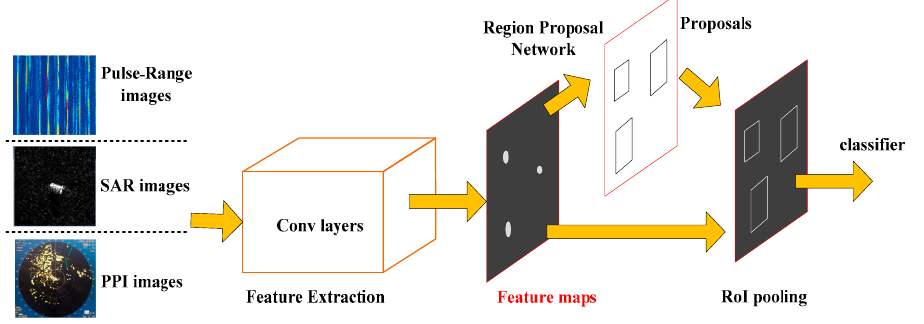
Figure 14. Basic structure of the Faster R-CNN.